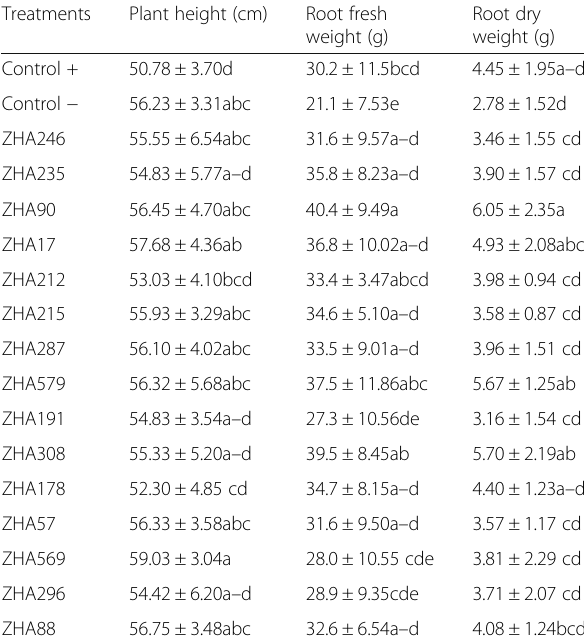
Table 2 Comparison of means of plant height, root fresh weight, and root dry weight of Meloidogyne incognita- inoculated tomato plants, following bacterial treatments (mean ± SD)